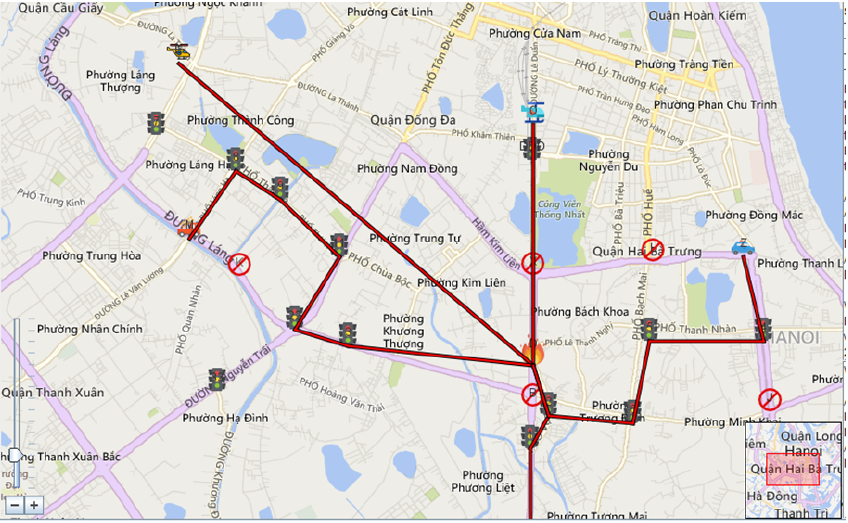
Figure 8. The route of service vehicles was appeared on the Google